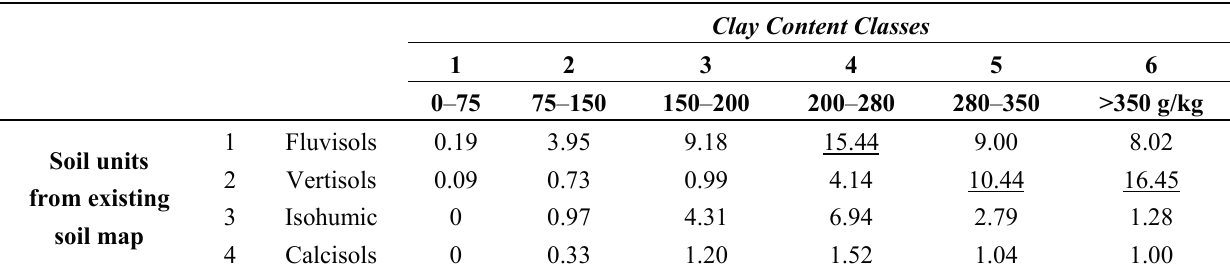
Figure 8. Comparison of observed topsoil clay content and cokriging predicted topsoil clay content at 50 independent sampling points. The dashed line is 1:1 line. Table 2. Area percentage of each combination between soil units and produced clay content map from Landsat TM data over an area of 13 km 2